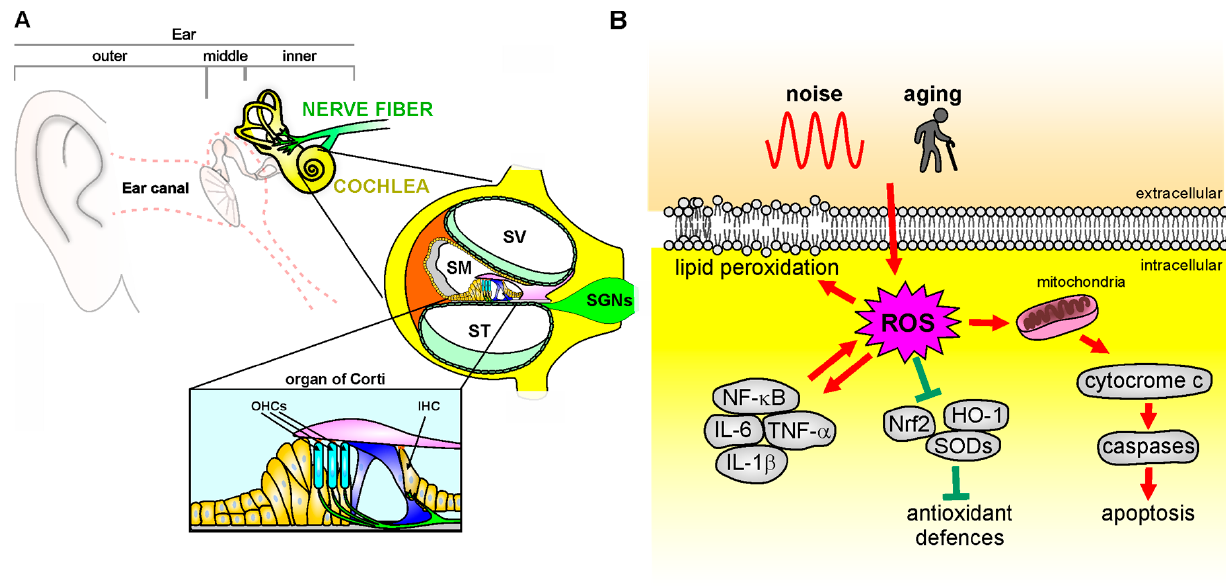
Figure 2. Mechanisms of oxidative stress in the cochlea. ( A ): Schematic representation of cochlear anatomy, with the organ of Corti, containing one row of inner hair cells (IHC) and three rows of outer hair cells (OHC), the main structure involved in oxidative stress attack. SV: Scala Vestibuli; SM: Scala Media; ST: Scala Tympani; SGNs: Spiral Ganglion neurons. ( B ): Noise or aging insults can induce oxidative damage leading to cytochrome c release from the mitochondria, which activates the caspase apoptotic pathway. ROS overload causes in parallel an imbalance of endogenous antiox- idant enzymes [Nrf-2, heme oxygenase-1 (HO-1), superoxide dismutases (SODs)] and an increase of pro-inflammatory markers (NF- κ B, TNF- α , IL-1 β ) that contributes to pro-apoptotic pathway ac- tivation, leading to cell death. Finally, ROS leads to increased lipid peroxidation, affecting plasma membrane